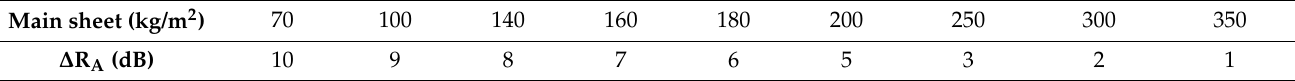
Table 3. Theoretical estimation of the sound reduction index improvement of additional